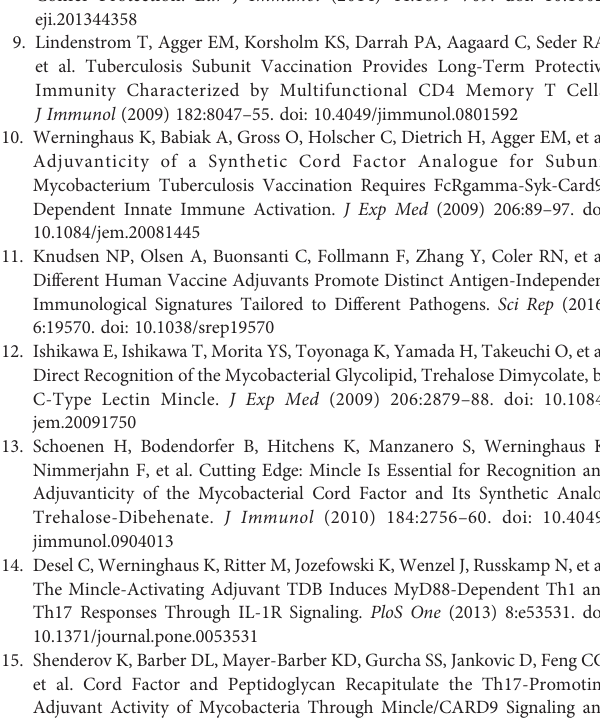
Supplementary Figure 2 | APC numbers and acquisition of adjuvant in the dLN. (A) Numbers of APC in popliteal lymph nodes 1d and 3d after s.c. footpad immunizationwithNBD-DDA/TDB. (B) Numbers ofadjuvant-positive APC;popliteal lymph nodes 1d and 3d p.i. Pooled data from 5 independent experiments. Supplementary Figure 3 | Depletion ef fi cacy of MC-21 (monocytes) or 1A8 (neutrophils). (A) Gating strategies for monocytes: P1&P3 (CD11b + Ly6C + Gr-1 int ) and neutrophils: P1&P2 (CD11b + Ly6C + Gr-1 high ) and dot plot examples. (B) Percentages in blood, pooled popliteal and inguinal lymph nodes or cells isolated from the footpad 7d p.i.; 5 mice per group. One of two experiments shown. (C) % monocytes and % neutrophils (D) in blood, popliteal lymph nodes or cells isolated from the footpad 24h p.i.; 3 mice per group, one experiment. Data presented as mean+SD; 1-way ANOVA and Dunnett ’ s post test (isotype as control group) p<0.05=*, p<0.01=**, p<0.001=***. Supplementary Figure 4 | CCR2 − / − do not have a general defect in Th1/Th17 response generation. (A) IFN g and IL-17 secretion after 48h polyclonal a CD3/ a CD28 stimulation (5µg/ml) of 5x10 5 splenocytes. Mean+SD; 2 mice per group, 1 of 2 representative. (B) TNF- a (bone marrow-derived macrophages) and G-CSF (bone marrow-derived DC) secretion after 48h stimulation with 100ng/ml LPS, 1.25µg/ml or 2.5µg/ml TDB or 1.25µg/ml TDM. Mean+SD from triplicates; 2.5x10 5 cells; 1 of 2 representative. (A, B) C57BL/6 (white bars), Ccr2 − / − (black bars). (C) Footpad swelling and cell counts from feet 7d post footpad immunization with DDA/TDB/H1 or CpG/H1. Supplementary Figure 5 | Cellular composition of the dLN is not altered in the absence of CCR2. Numbers of cells isolated from popliteal lymph nodes 1d and 3d after footpad immunization with NBD-DDA/TDB. Pooled data from 2 independent experiments with a total of 5-6 mice per group/time point. Signi fi cance tested by